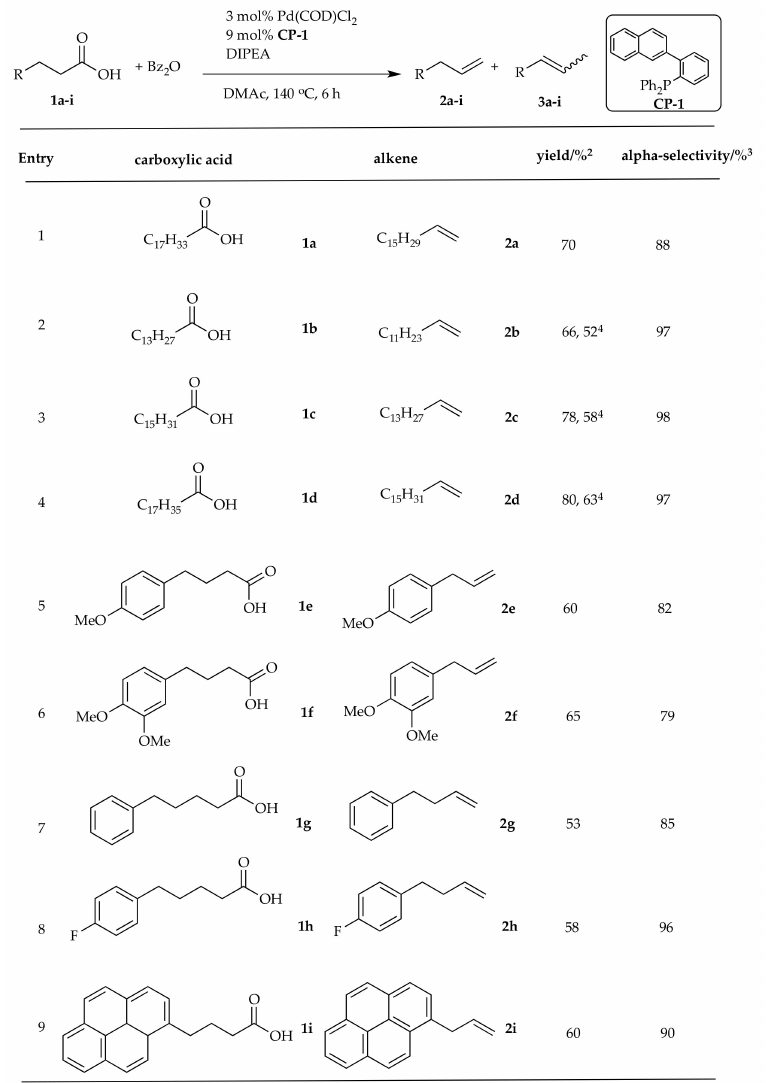
Figure 3. Pd-catalyzed decarbonlyation of carboxylic acids to alpha alkenes. 1 Reaction conditions: 0.5 mmol carboxylic acid, 3 mol% Pd(COD)Cl 2 , 9 mol% CP-1, 2 equiv. Benzoic anhydride, 3 equiv. DIPEA, 1mL DMAc, 140 ◦ C, 6 h. 2 Isolated yield. 3 alpha-selectivity was determined by 1 H NMR. 4 1 mol% Pd(COD)Cl 2 (Pd:L = 1:3) were